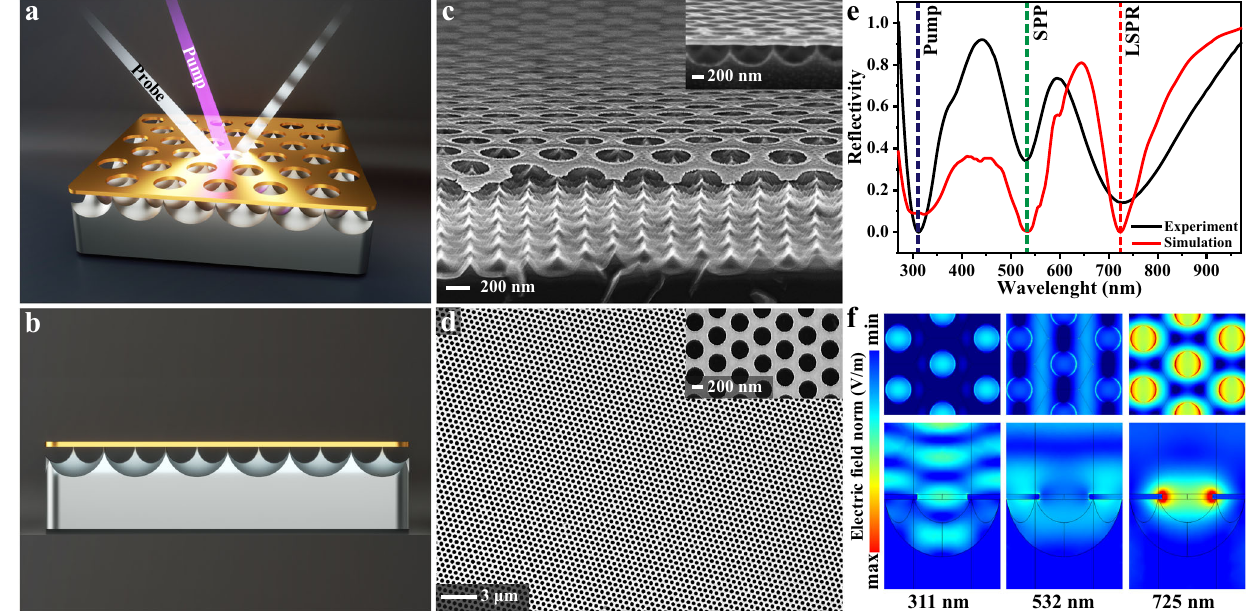
Fig. 1 | Structural and steady-state optical measurements and simulations. a Concept image showing the vibrational response of the probe signal through opticalexcitationoftheTSNOMS. b ConceptimageoftheTSNOMS. c , d SEMimage